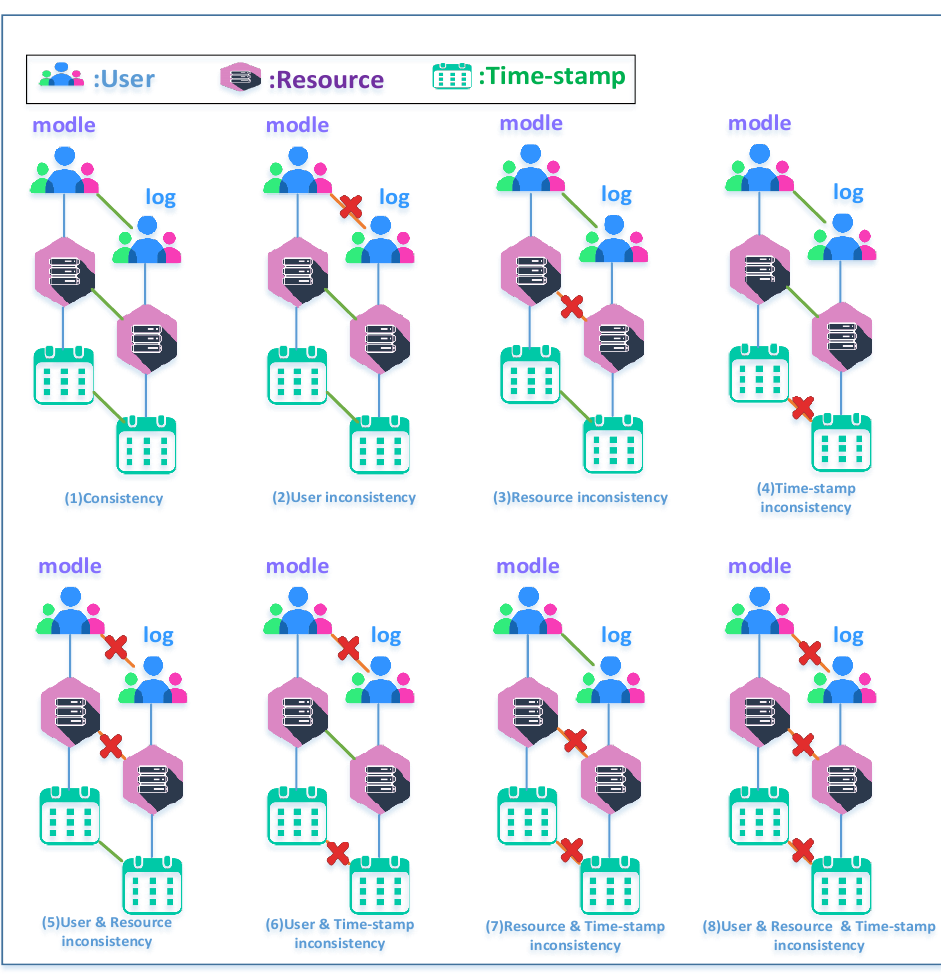
Figure 5. Attribute Matching.